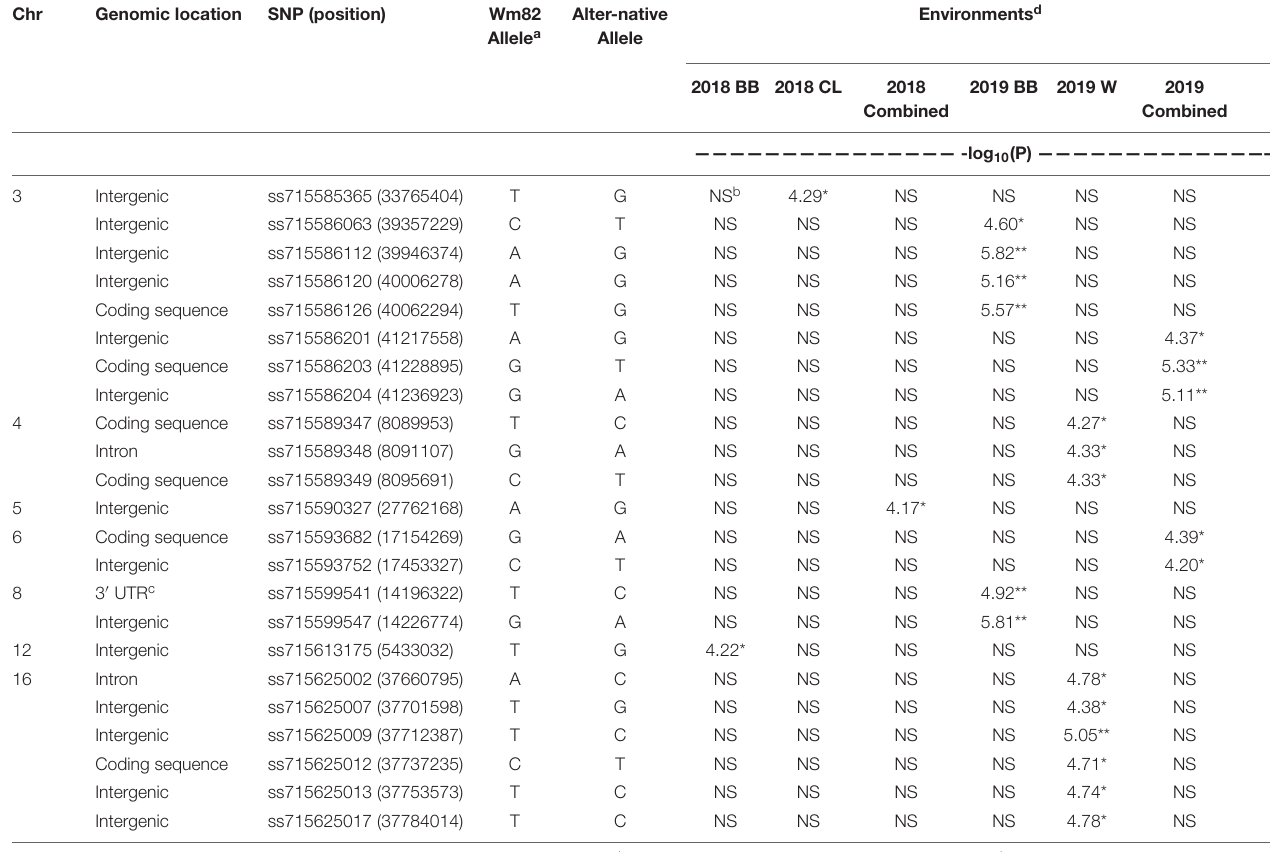
TABLE 2 | Significant SNPs on chromosomes 3, 4, 5, 6, 8, 12, and 16 associated with Met content (g kg − 1 cp) in soybean seeds. Chr Genomic